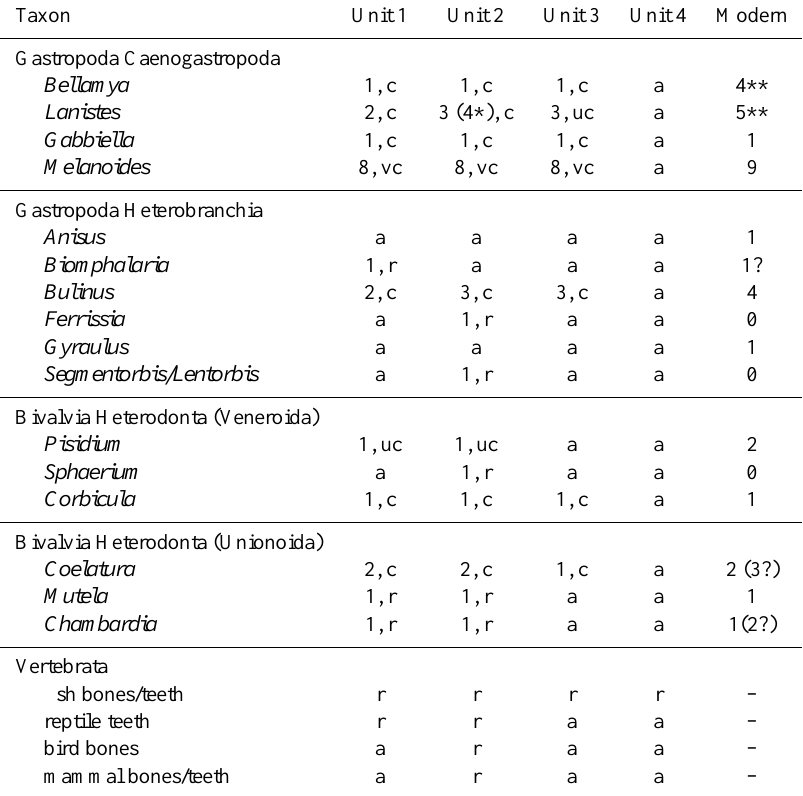
Table 2. Fossil finds in the units of the Chipalamawamba Beds compared to the modern mollusk fauna of the Malawi Basin (updated from Mandahl-Barth, 1972). Numbers indicate how many morphospecies are recognized per genus; one asterisk (*) marks the number of morphs after inclusion of fossil material collected by A. Gorthner; two (**) indicates that deep-water species are included. Mollusk finds not identifiable to genus level were excluded. Doubtful occurrences in the Malawi Basin are flagged with question marks, vc = very common, c = common, uc = uncommon, r = rare, a =